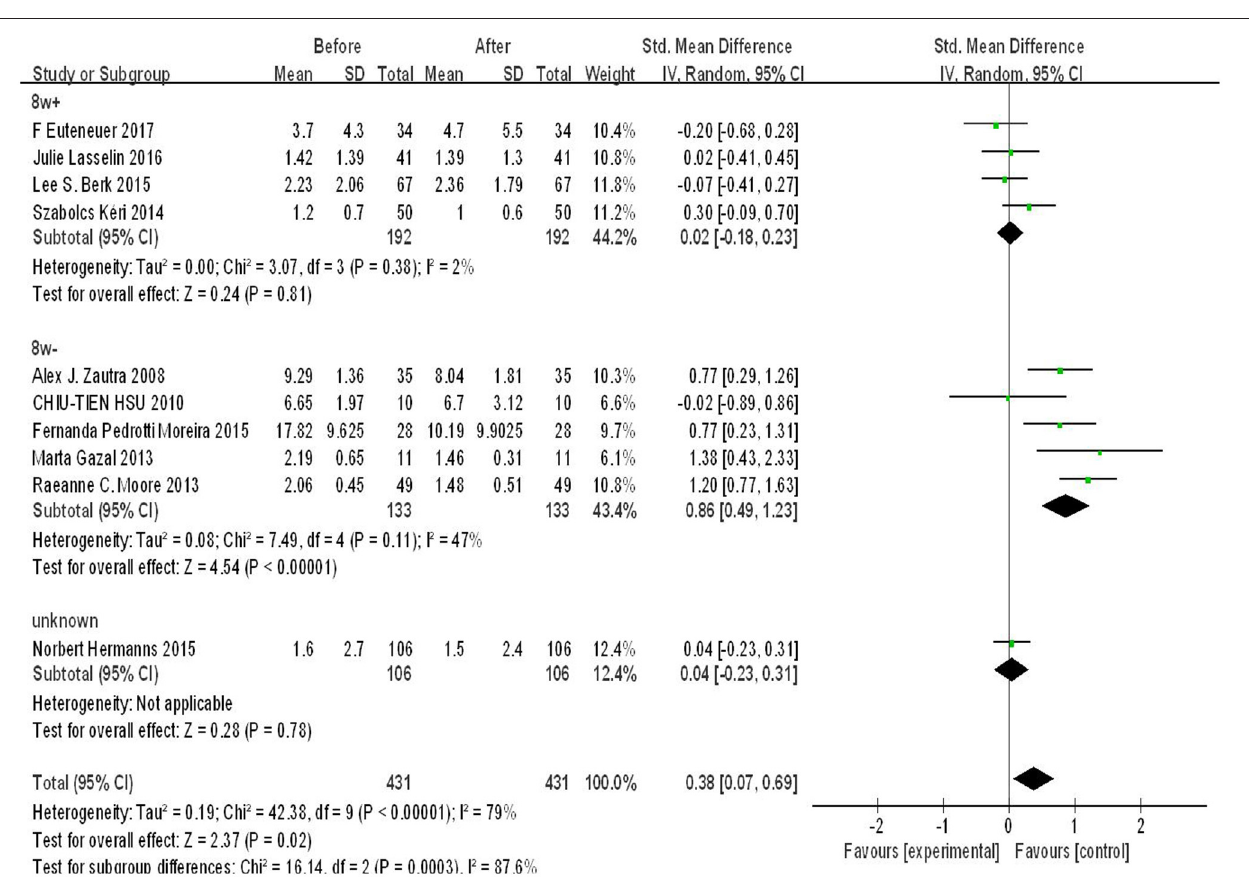
FIGURE 3 | Forest plot for change in IL-6 before and after CBT with CBT intervention duration of 8